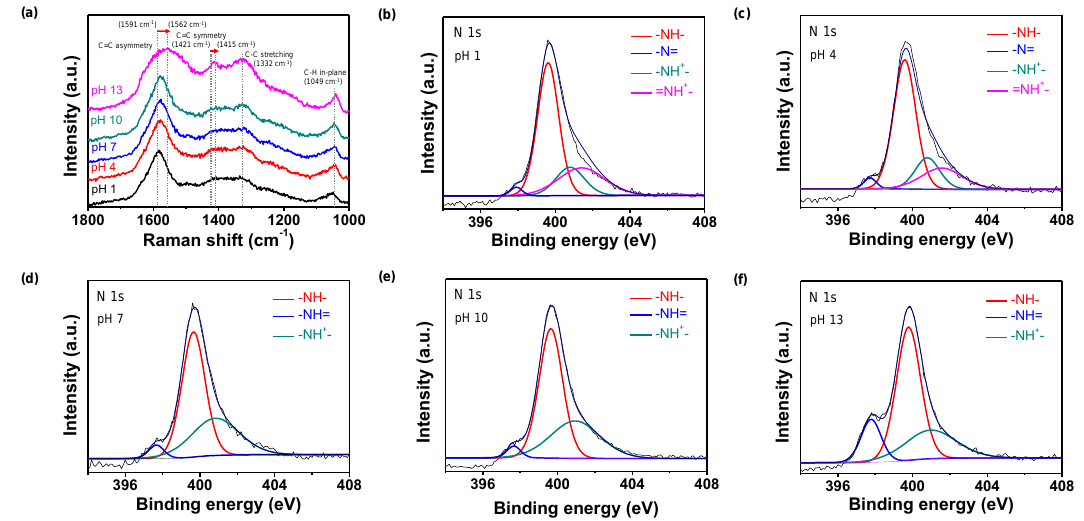
Figure 2. ( a ) Ultra-violet visible and near infra-red (UV-vis-NIR) absorption spectra of polypyrrole nanoparticles (PPyNPs) at different pH values. ( b ) Normalized absorption spectra of PPyNPs with a change in pH at different wavelengths (black for 300 nm, red for 450 nm, and blue for 1000 nm).